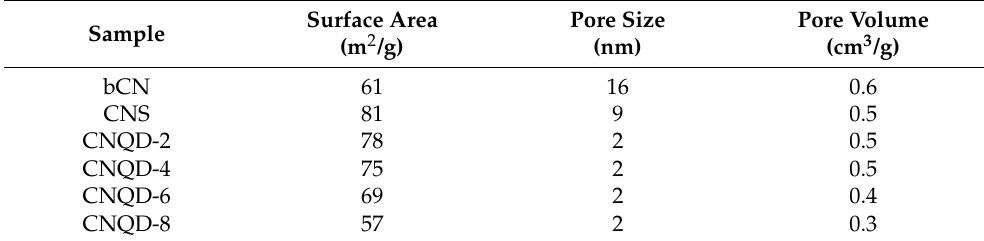
Table 2. Surface properties of bCN, CNS, and CNQD